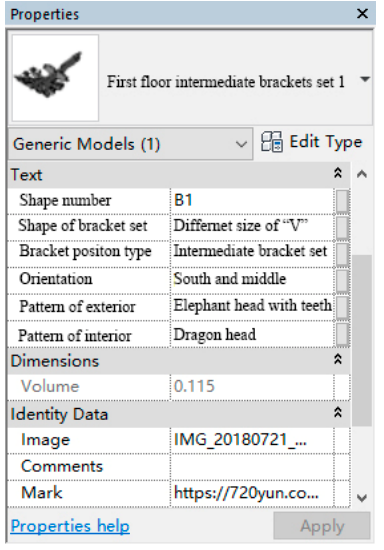
Figure 16. Archaeological data interpretation and identification.